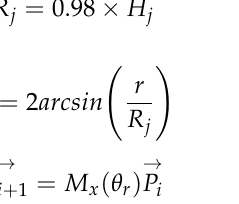
Figure 5. Detection ball and detection discs.